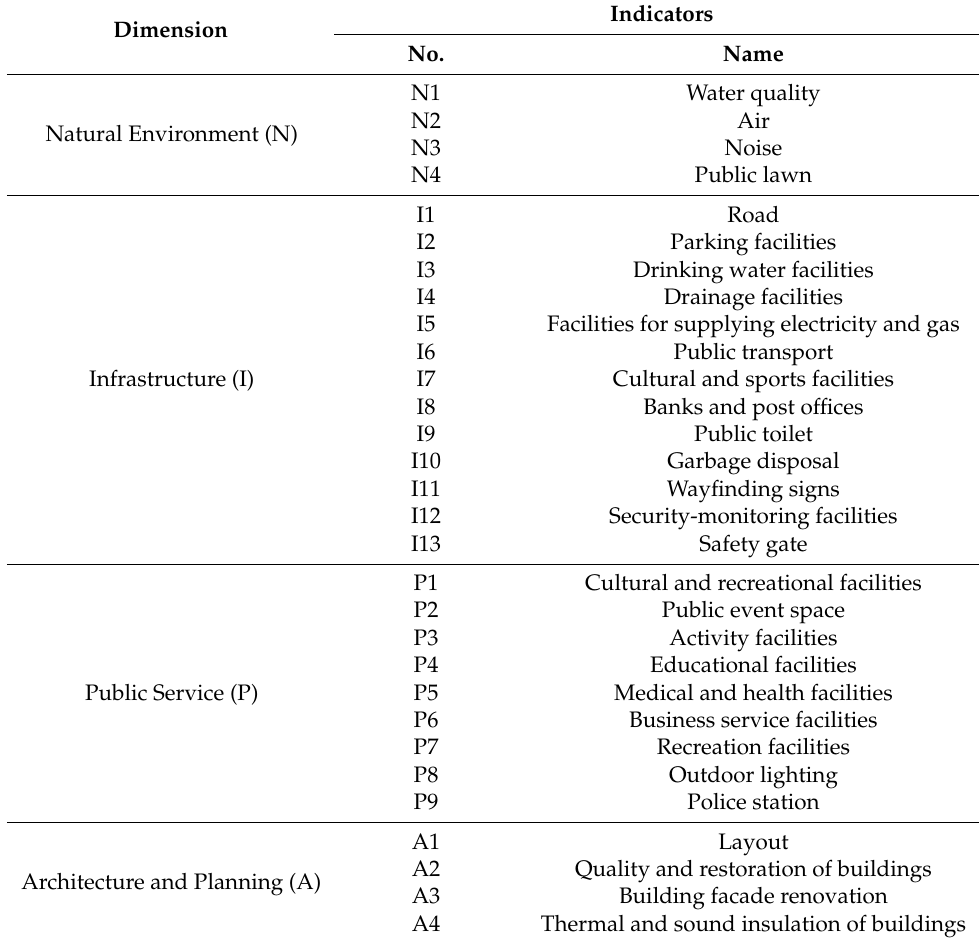
Table 2. The sustainable renovation indicators of living environment in rural settlements.